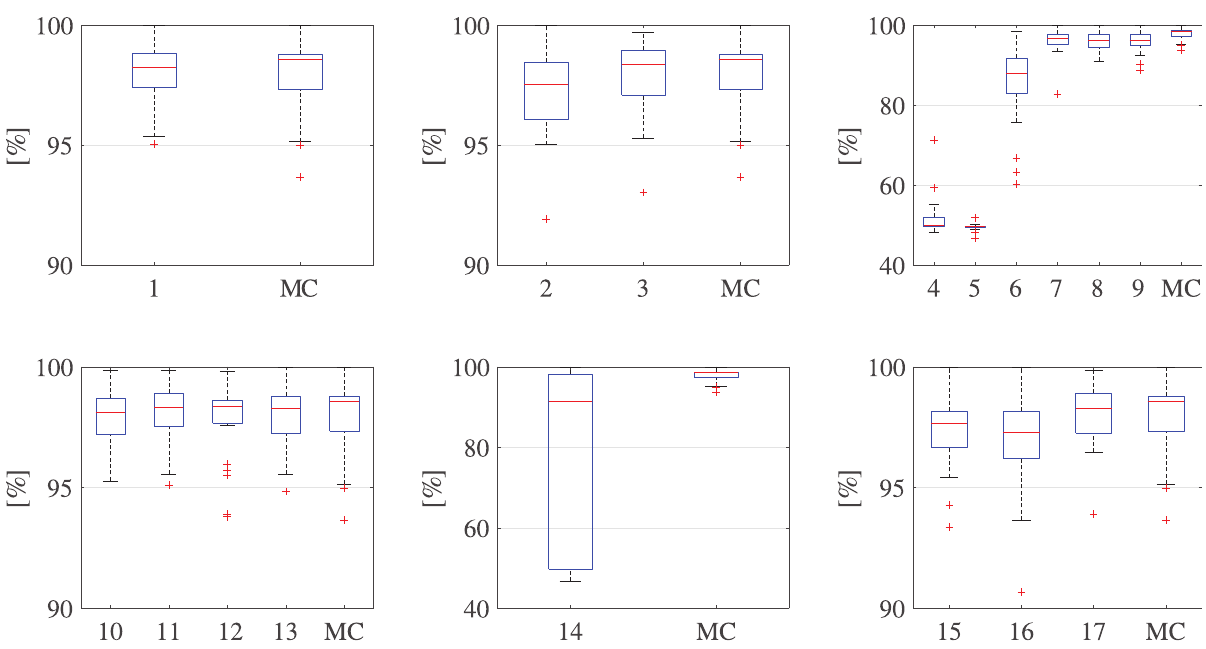
Fig 8. Assessment of individual processing steps. Accuracies (percentages) of the six steps (from left to right, top to bottom) identified in Fig 3. For the numbering used to identify these chains, refer to Table 2.